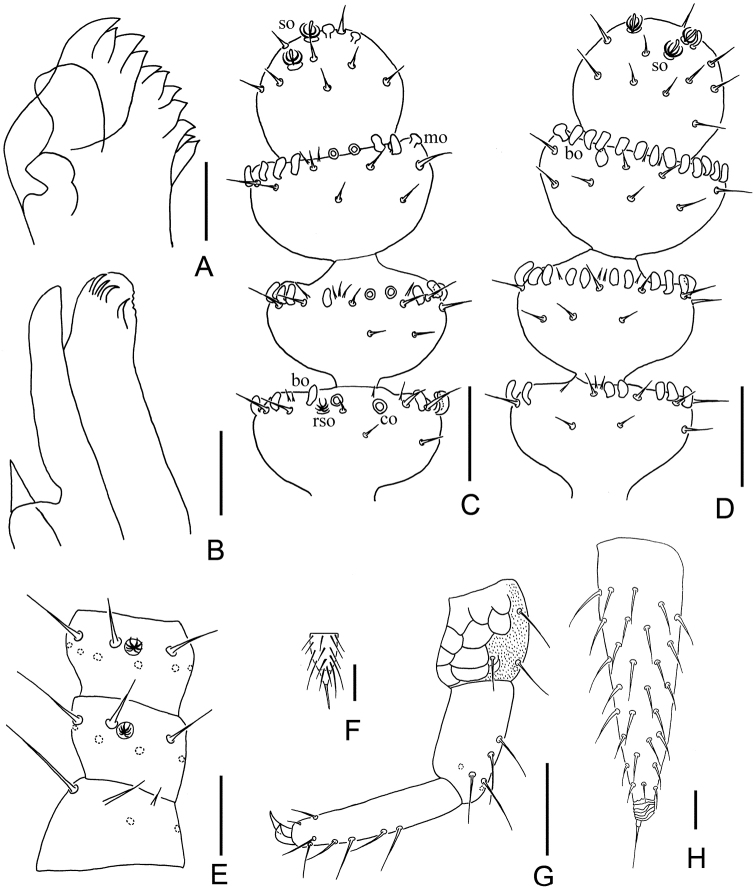
Symphylellazhongi sp. n. A mandible B first maxilla C–D 18th–21th segments of right antenna C dorsal view (bo-bladder-shaped organ, co-cavity-shaped organ, mo-mushroom-shaped organ, rso-rudimentary spined sensory organ, so-spined sensory organ) D ventral view E 1st–3rd segments of right antenna, dorsal view F stylus on base of 5th leg G 12th leg H right cercus, dorsal view. Scale bars: 20 μm (A–E, G, H); 5 μm (F).